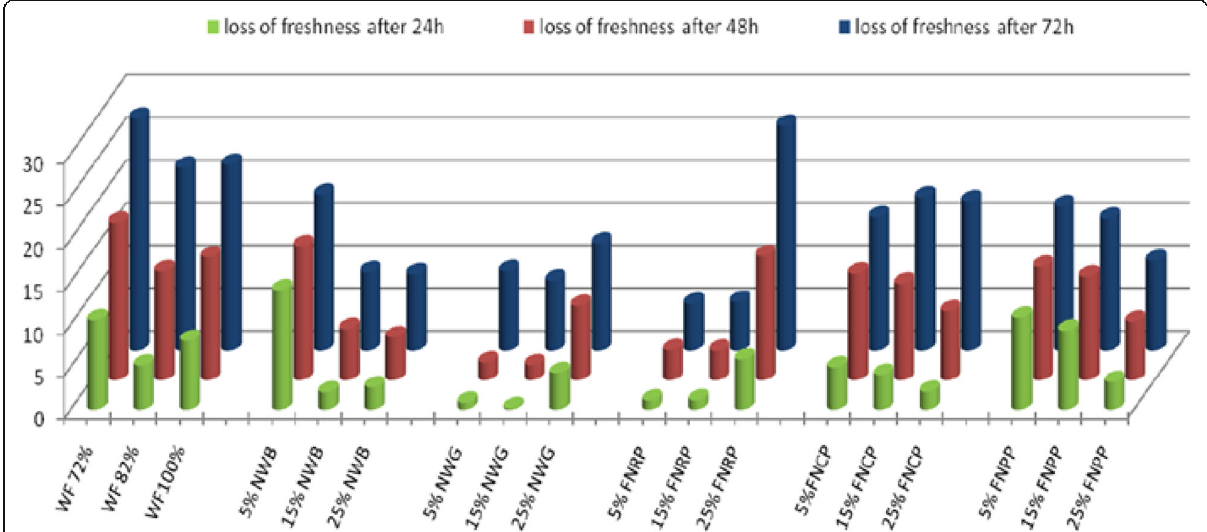
Fig 3 Loss of freshness in pan bread during storage as affected by addition of nano and fermented nano materials. WF, wheat flour; NWB, nano- wheat bran; NWG, nano-wheat germ; FNCP, fermented nano-carrot pomace; FNPP, fermented nano-pomegranate